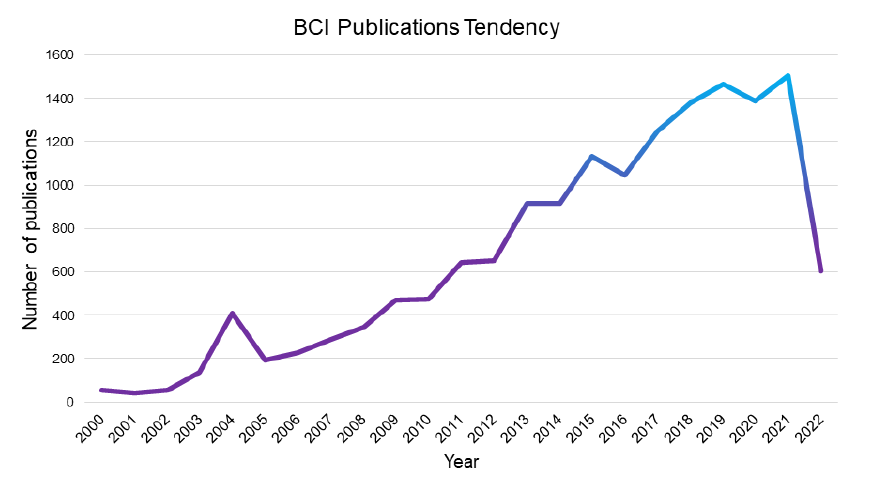
Figure 3. BCI tendency of number of publication by